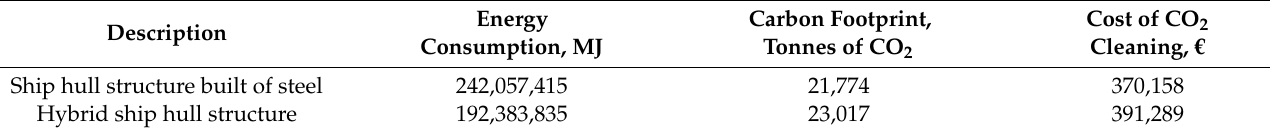
Table 2. Carbon footprint of ship construction.